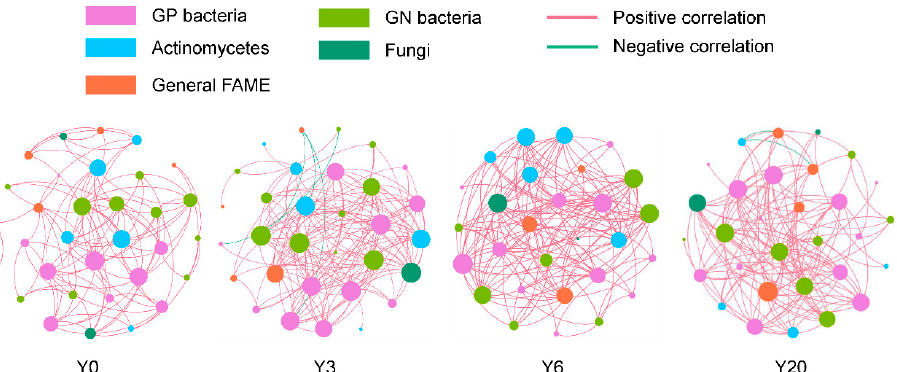
Figure 3. Network analysis of co-occurring PLFAs under different mugwort cropping years. Nodes with different colors represent the individual PLFA biomarkers. Solid red and blue lines represent positive and negative correlations, respectively. General FAME: unspecific biomarkers. See Figure 1 for abbreviations.